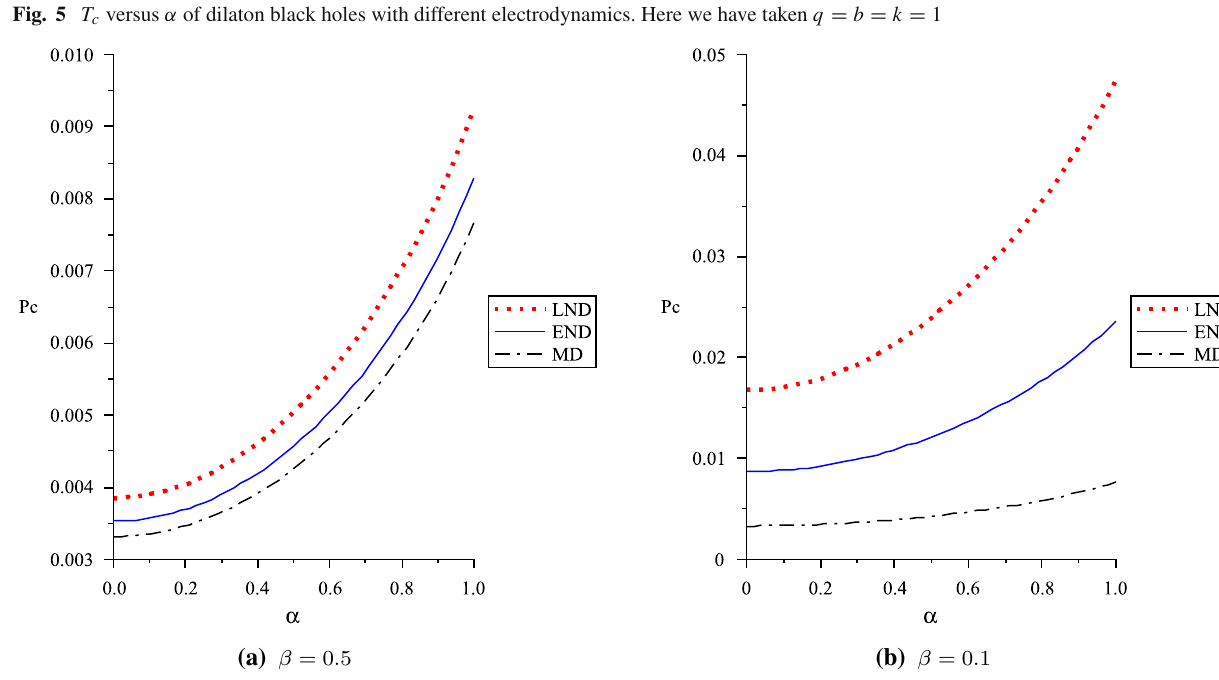
Fig. 6 P c versus α of the black holes in different electrodynamics with q = b = k =